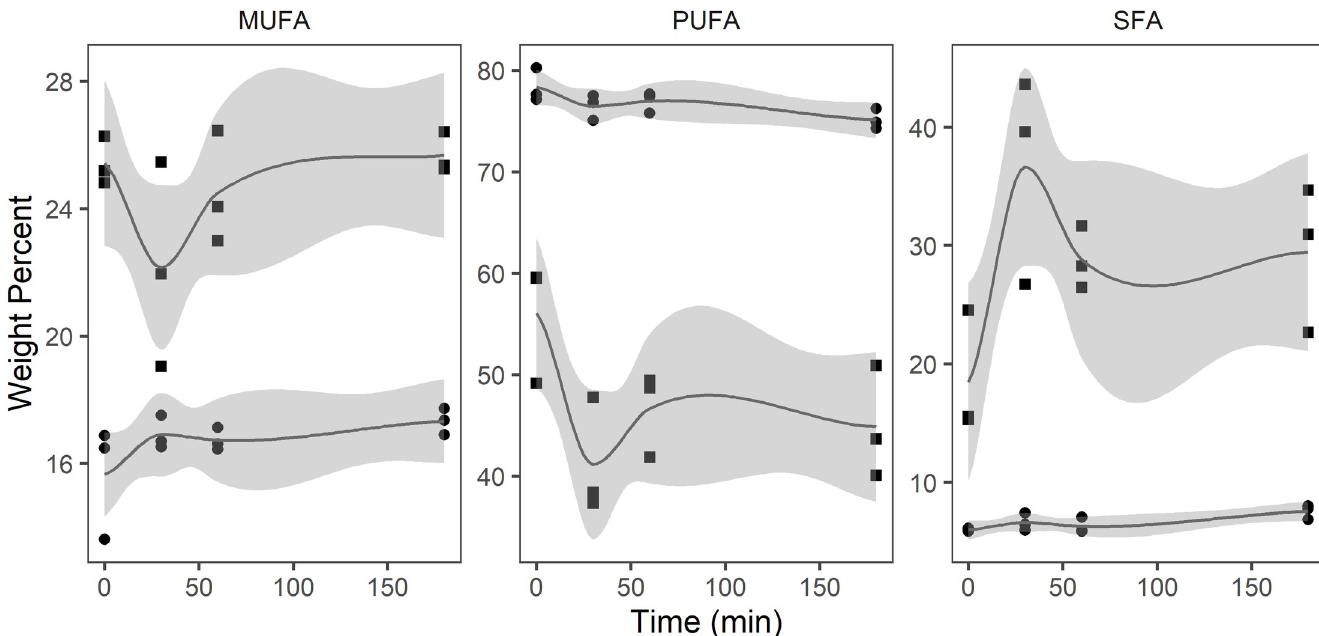
Fig 4. Monounsaturated fatty acids (MUFA), polyunsaturated fatty acids (PUFA), and saturated fatty acids (SFA) (weight percent) in free fatty acid (square) and neutral lipid (circle) fraction of the ethyl ester concentrate (n = 3) during in vitro digestion.